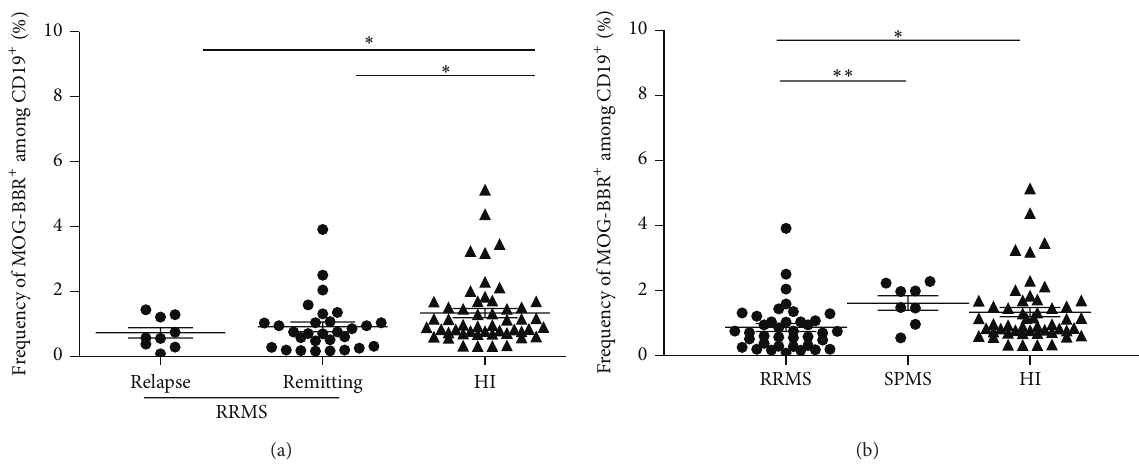
Figure 3: Quantification of MOG-specific B cell frequencies in MS patients according to disease activity and MS forms. (a) RR patients were classified according to disease state, for example, relapse or remission. We analysed the difference in MOG-BBR frequencies for patients in relapse ( 𝑛 = 9 ) and patients in clinical remission ( 𝑛 = 29 ) versus HI ( 𝑛 = 50 ) ( 1𝑃 < 0.05 ), Kruskal-Wallis test . No difference between patients in relapse and patients with clinical remission was observed (ns, 𝑃 > 0.05 ). (b) Eight patients with secondary progressive (SP) forms were included and compared to RR patients and HI. There was a statistically significant difference between SPMS patients and RR MS patients ( 𝑃 < 0.05 ) but not between SPMS patients and HI ( 𝑃 > 0.05 ), Kruskal-Wallis test .